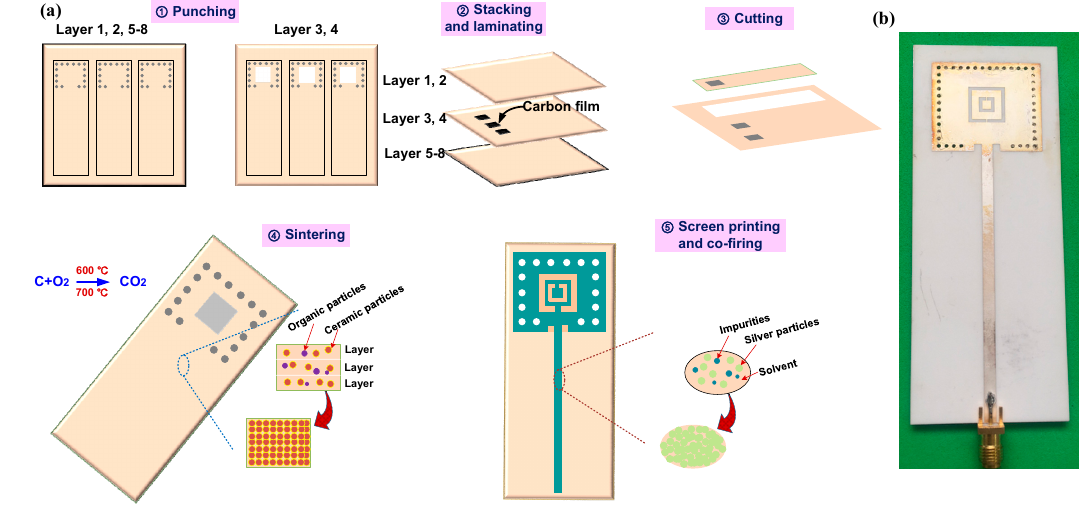
Figure 6. ( a ) The process of sensor fabrication; ( b ) the fabricated sensor.